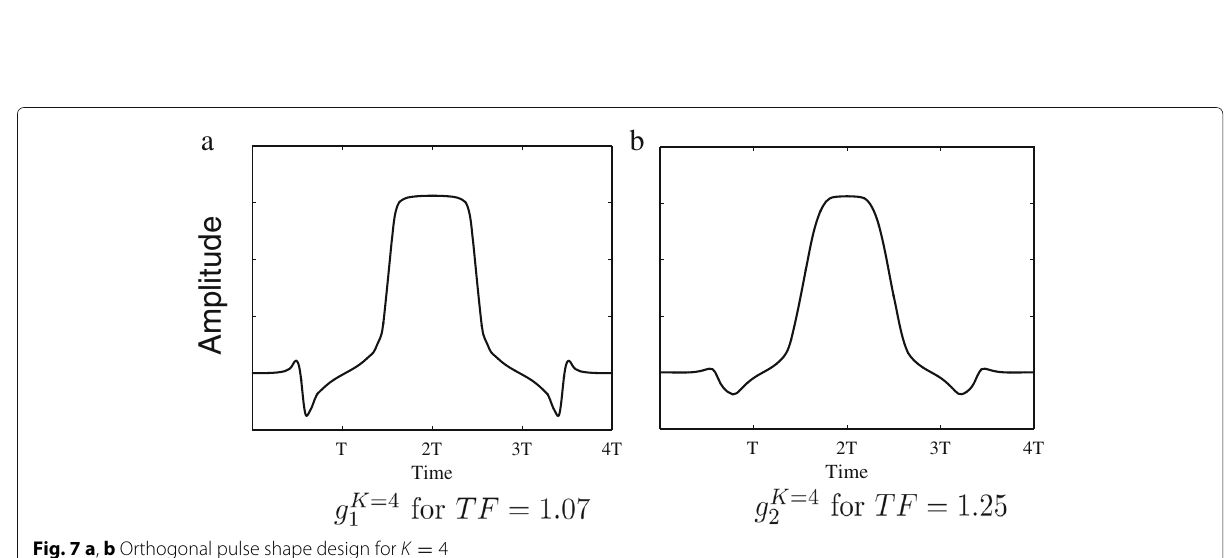
Fig. 7 a , b Orthogonal pulse shape design for K = 4